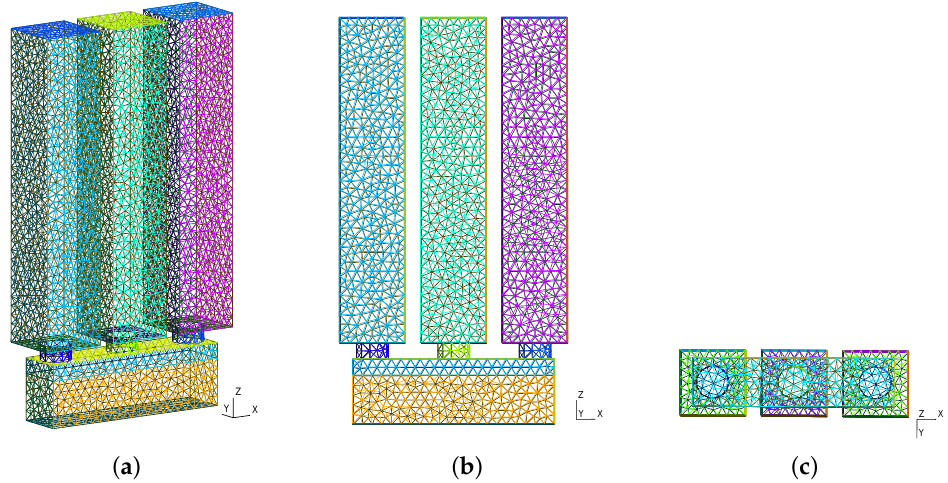
10 cm, located (cid:31)